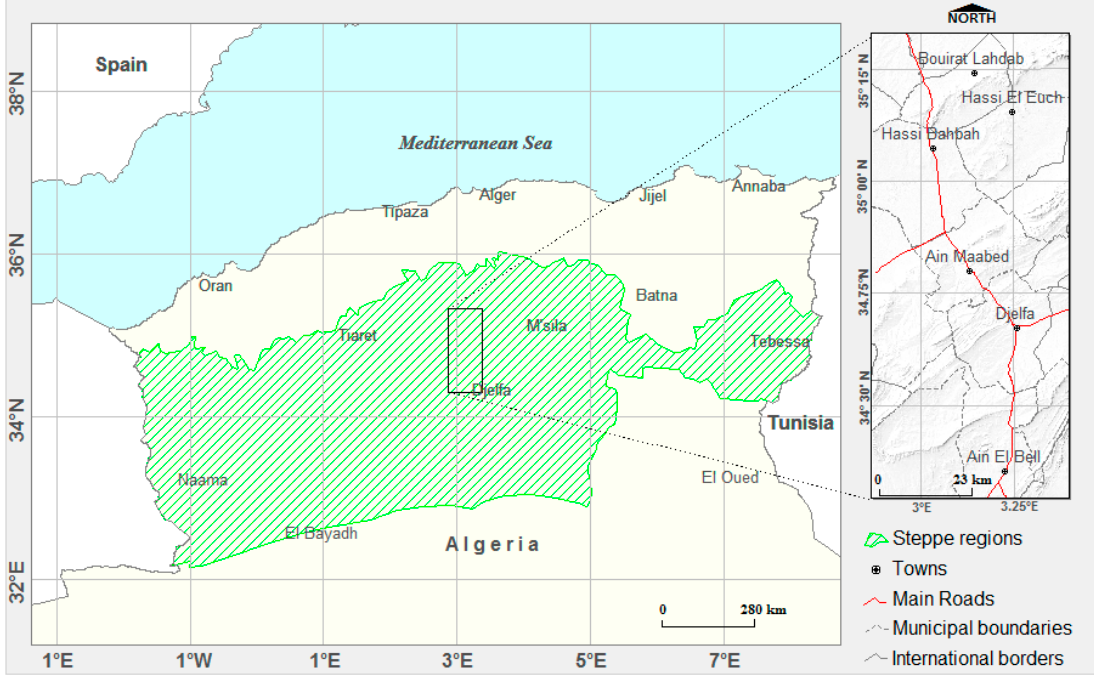
Figure 1. Simplified map of North Algeria showing the steppe zone examined in this study. The black rectangle indicates the studied area with a hill shade map.